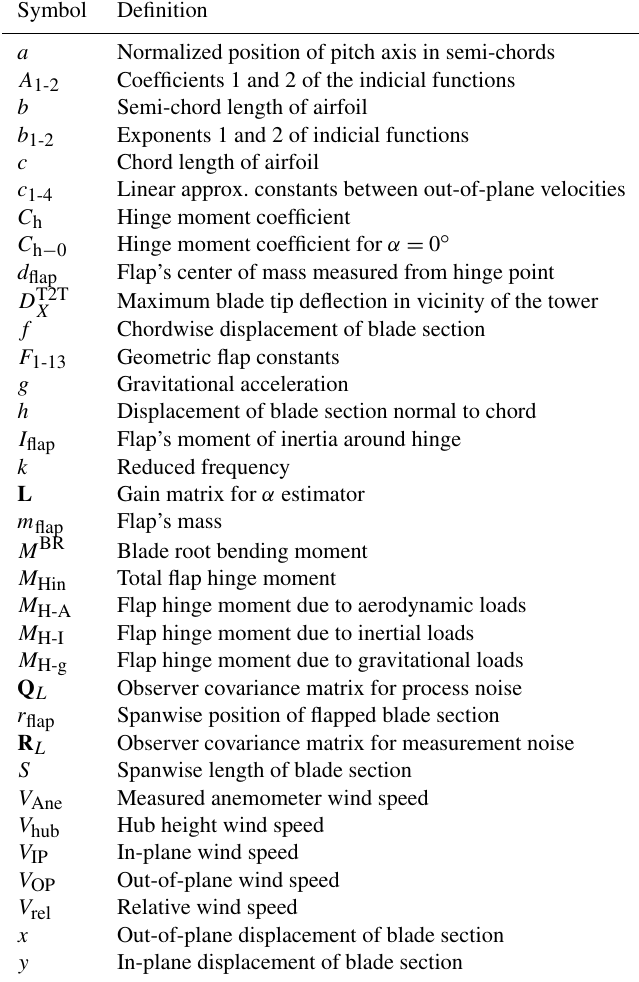
Table B1. List of Latin symbols used in this